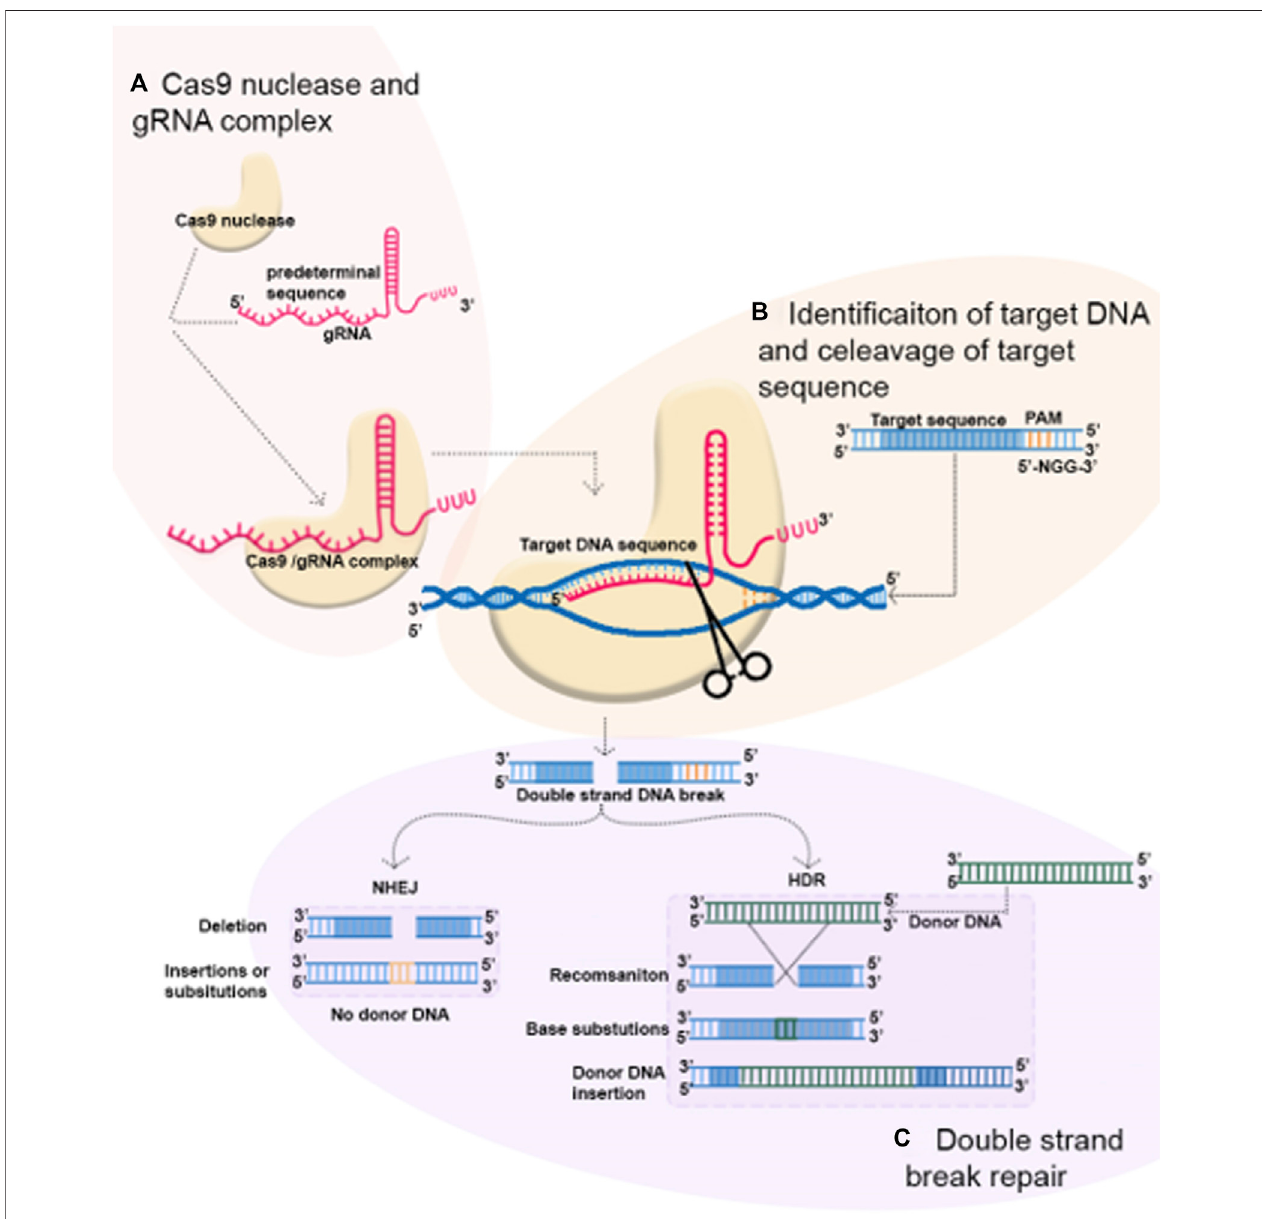
FIGURE1| MechanismofCRISPR-Cas9genomeediting. (A) CRISPR-Cas9systemiscomposedoftheCas9proteinandgRNAandCas9/gRNAcomplexoccur. (B) Cas9/gRNA complex cleave targets DNA in a binary complex, causing a double-stranded DNA break. (C) DNA breaks are repaired by non-homologous end joining (NHEJ) and homology-directed repair (HDR). In the process, short insertion deletions, nucleotide substitutions, or gene insertion may occur.